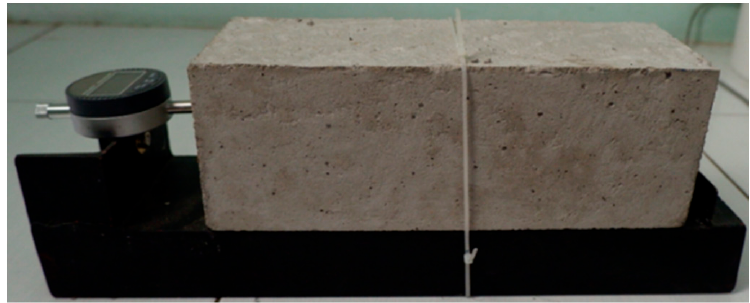
Figure 3. Set-up of digital micro indicator.